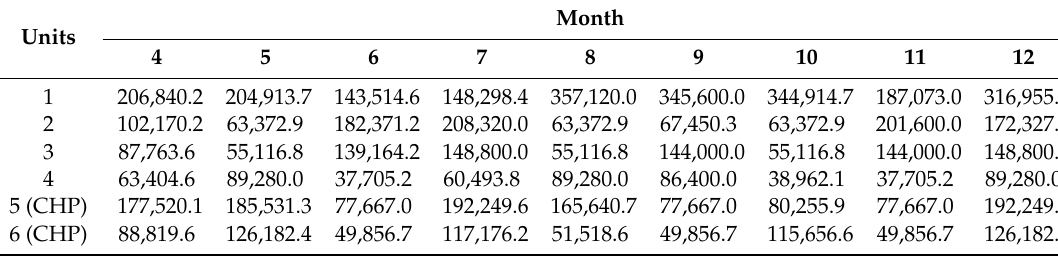
Table 10. The scheduled energy of thermal power units using the proposed